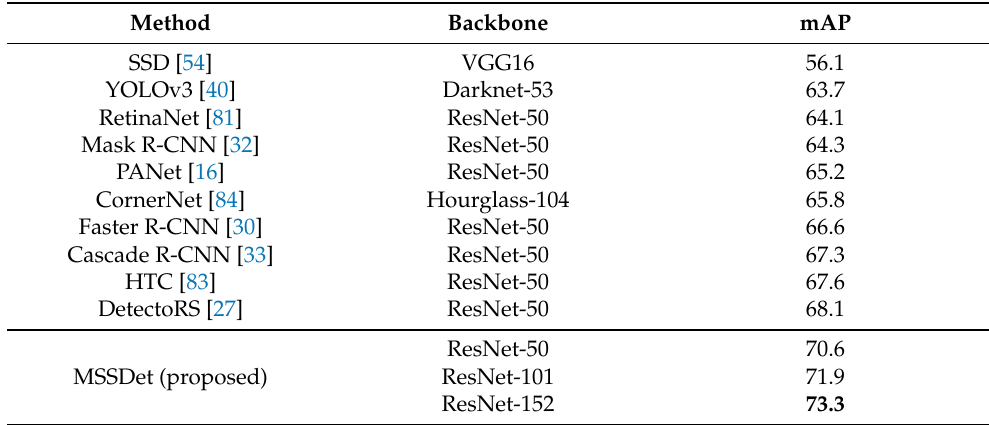
Table 4. Comparison with state-of-the-art methods on DIOR dataset. Note that the semantic branch in HTC is removed due to semantic segmentation annotations not being available in the DIOR dataset. The best result is highlighted in bold.